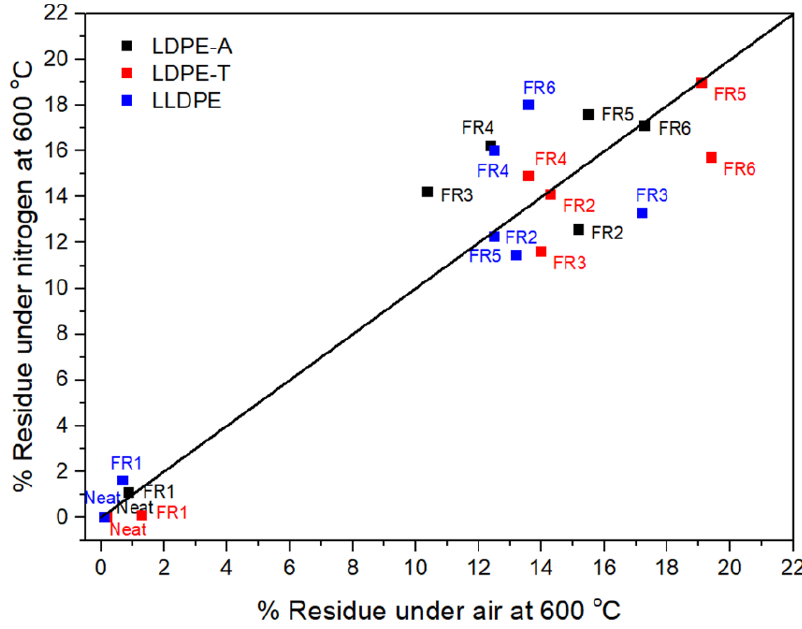
Figure 3. TGA residue (%) under nitrogen and air atmosphere for the FR-containing compounds.